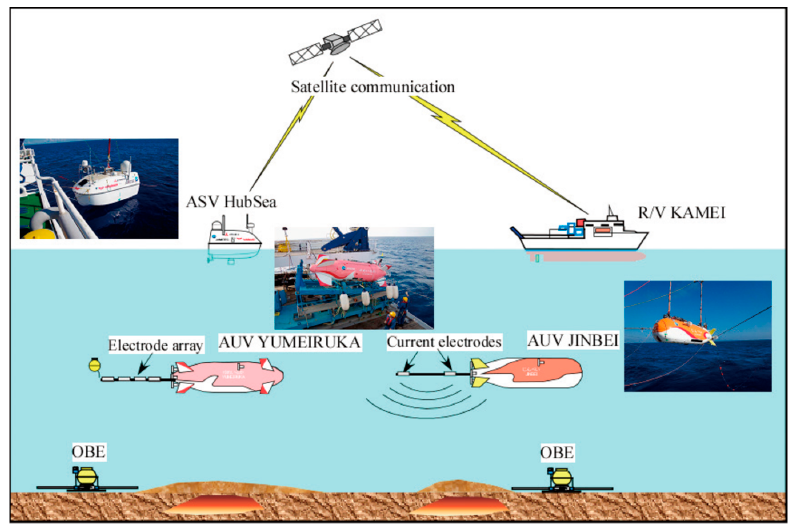
Figure 37. Sketch of exploration using two autonomous water vehicles (AUVs) and an autonomous surface vehicle (ASV) (see Kasaya et al., 2020 [116], for details). These types of equipment could be revolutionary for the exploration of ore bodies at the seafloor by using a combination of self-potential, resistivity, and induced-polarization data. Since the methods have different sensitivities with respect to the ore bodies, the combined tomograms could provide a highly efficient method to image ore bodies at the seafloor.